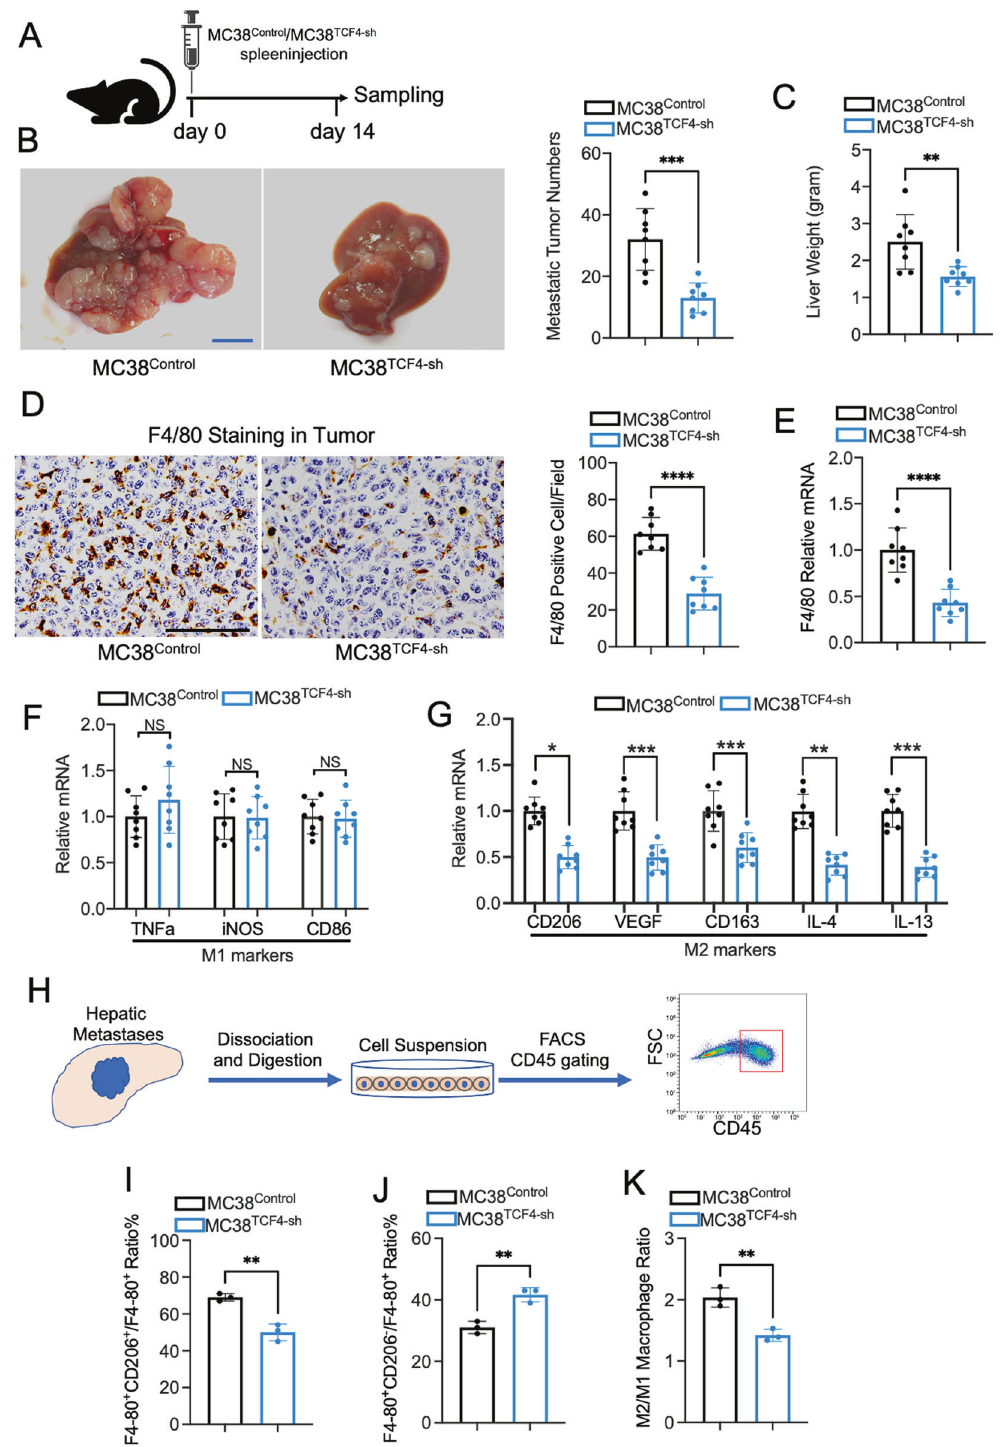
Fig. 4 De fi ciency of TCF4 expression in MC38 cells signi fi cantly reduces TAM recruitment and M2 polarization in the hepatic metastatic tumor of the mouse model. A The schematic protocol of the mouse model received MC38 spleen injection. B Representative images and quanti fi cation of tumor numbers of mouse liver with colorectal cancer metastases. n = 8 per group; Scale bar, 10 mm. C The liver weight of the mice was evaluated. D F4/80 Immunohistochemistry staining and quanti fi cation in the metastatic tumor region. n = 4 per group; Scale bar, 100 μ m; fi ve fi elds were counted per sample. E F4/80 mRNA expression in the tumor was analyzed by Q-PCR. F Q-PCR analysis of M1 macrophage marker expression in the tumors. G M2 macrophage markers CD206, VEGF, CD163, IL-4, IL-13 mRNA expression in tumors. H Illustration of fl ow cytometry analysis using hepatic metastases tissue of mouse model. I M2 macrophage(F4-80 + CD206 + )/total TAM(F4-80 + ) ratio in tumors. J M1 macrophage (F4-80 + CD206 - )/total TAM(F4-80 + ) ratio in tumors. K Quanti fi cation of M2/M1 ratio in hepatic metastatic tumor of mouse model. Data are means ± SEM. * P < 0.05, ** P < 0.01, *** P < 0.005, **** P <